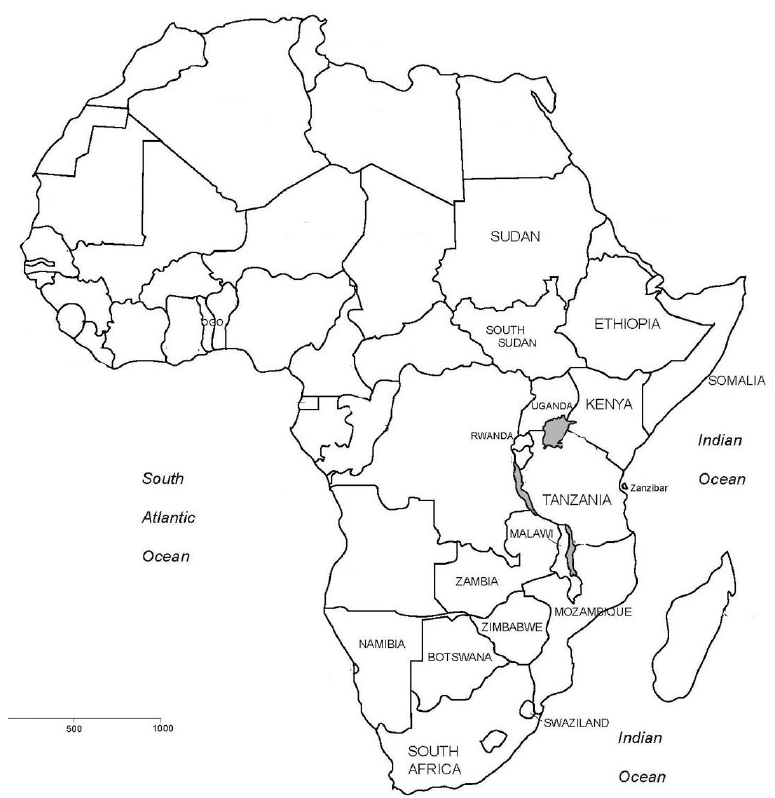
Figure 2. Countries in which Lannea schweinfurthii has been recorded in south, central and east Africa.